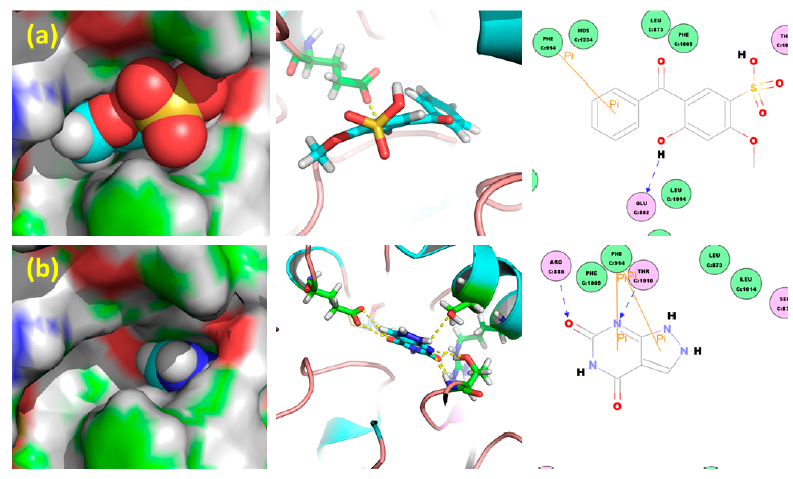
Figure 2. Docked structures of ( a ) HMS and ( b ) oxypurinol to XOD (PDB: 1FIQ).